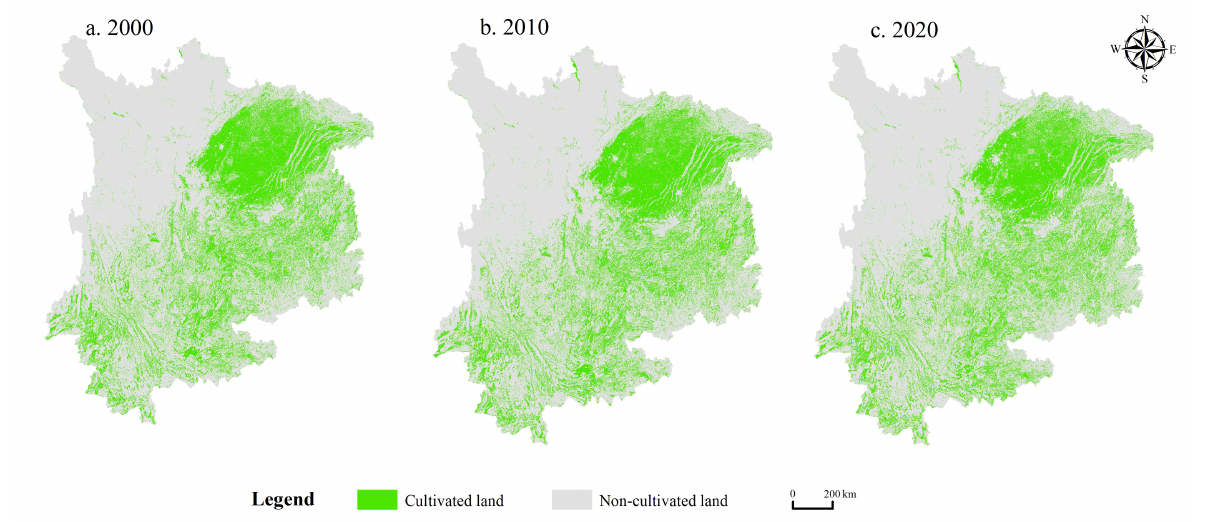
Figure 3. Distribution of cultivated and non-cultivated land.